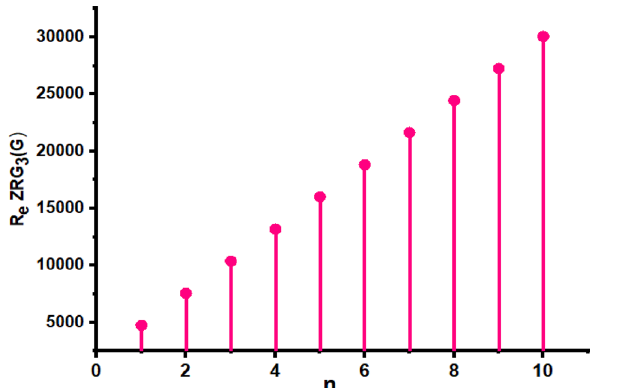
Figure 8. The comparison of n and . R e ZRG 3 ( G )